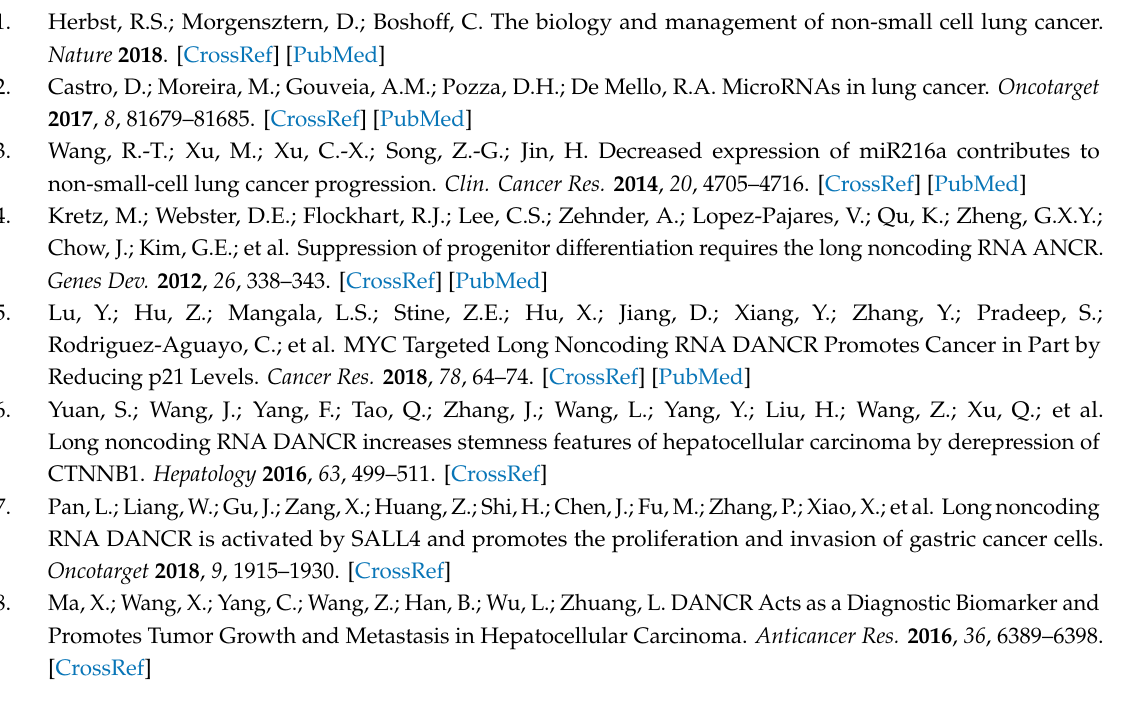
Figure S1. (A) qRT-PCR measuring fold change of DANCR expression in stable A549 DANCR KD compared to scramble control ( n = 3, t test, **** p < 0.0001); (B) cell growth of stable A549 DANCR KD cells compared to scramble control ( n = 3, 2-way ANOVA, * p < 0.05, ** p < 0.01, *** p < 0.001, **** p < 0.0001); (C) cell impedance assay of stable A549 DANCR KD cells compared to scramble control (representative of 3 independent experiments); (D) colony formation of stable A549 DANCR KD cells compared to scramble control ( n = 3); (E) qRT-PCR of DANCR expression in A549 cells cotransfected with DANCR shRNA + TOPFlash luciferase vector compared to scramble + TOPFlash luciferase vector ( n = 3, t test, * p < 0.05, ** p < 0.01). Figure S2. Representative images of e ff ect of DANCR KD on clonogenic growth in (top) A549 and (bottom) H1755 cells compared to scramble